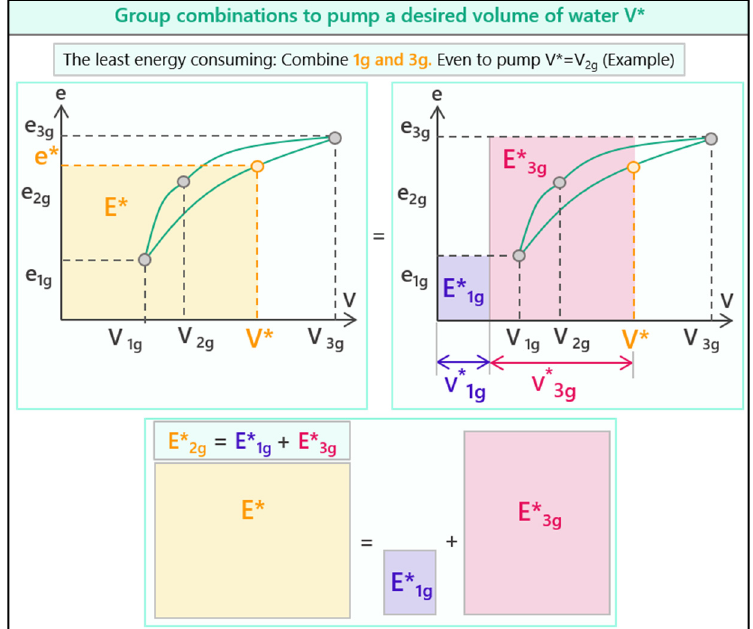
Figure 11. Conservation of the energy. Solution of the specific energy e* of the example case, where the station would combine n g = 1 and n g = 3. The average specific energy e* will be the sum of the energy spent when the station is working with n g = 1 and when the station works with n g = 3.